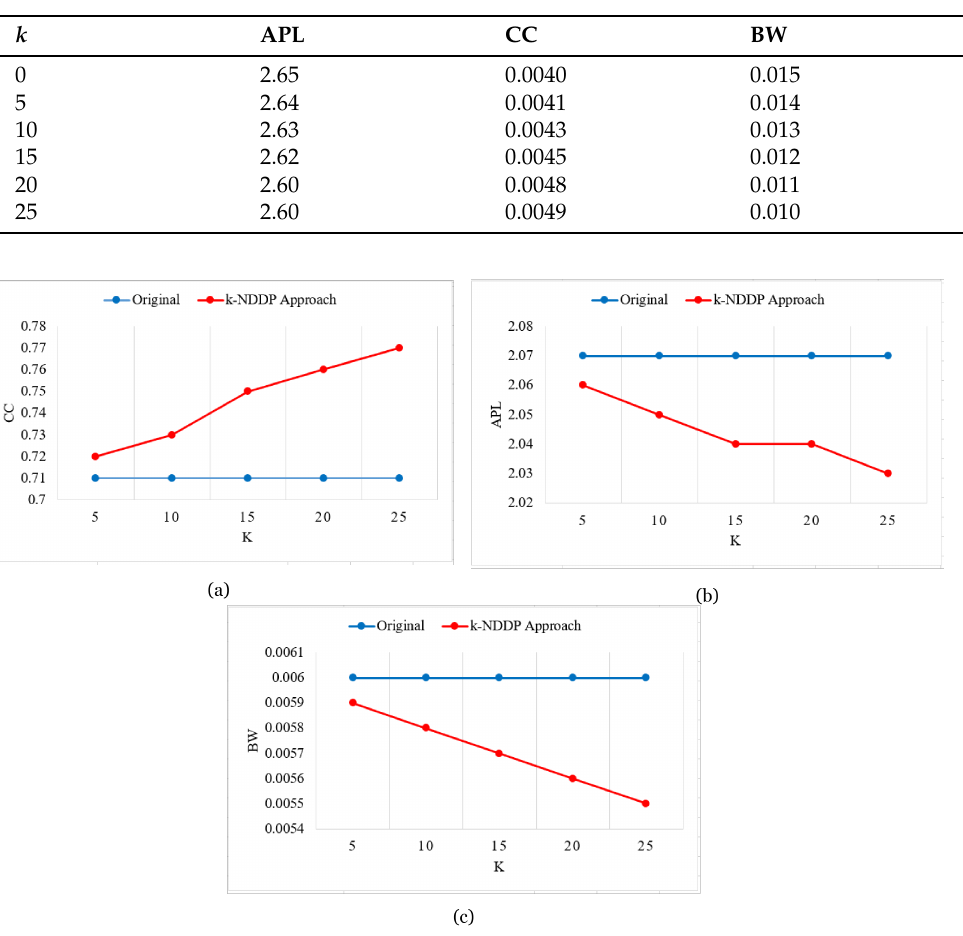
Figure 7. Comparison of k -NDDP with k -NMF(FEATHER-DEEZER-SOCIAL). ( a ) CC ( b ) APL ( c )